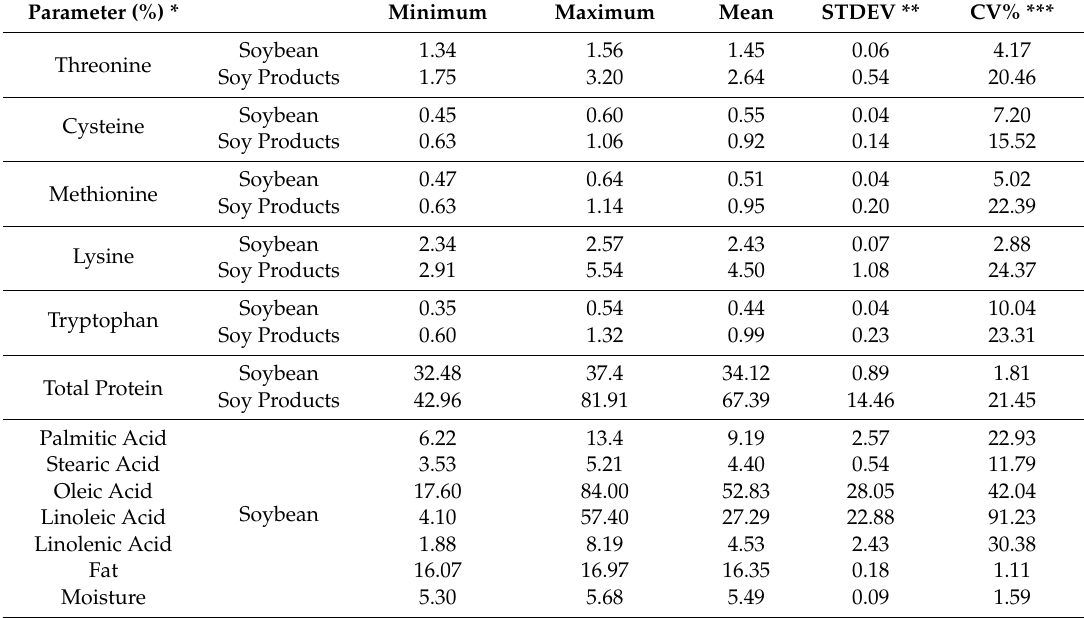
Table 1. Reference analysis results for essential amino acid (lysine, threonine, methionine, tryptophan, and cysteine), total protein, major fatty acid (palmitic, stearic, oleic, linoleic, and linolenic), fat, and moisture content in soybeans and soy